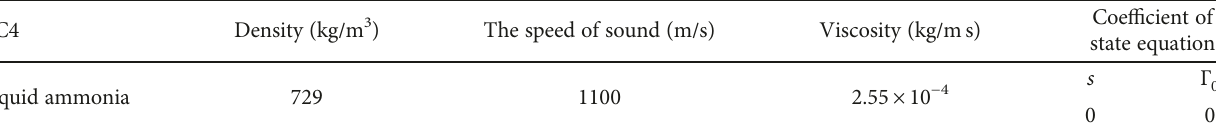
Table 3: The performance parameters of the liquid ammonia.